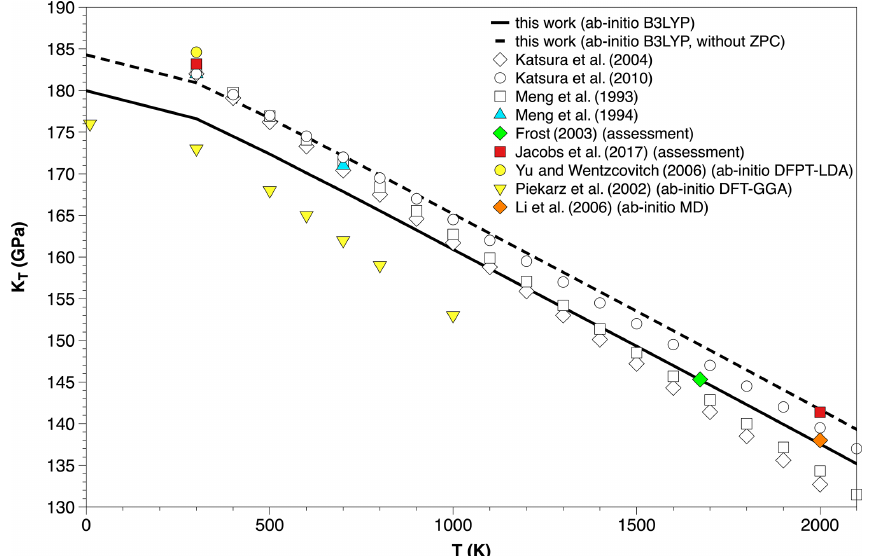
Figure 2. Temperature dependence of the isothermal bulk modulus ( K T ) of Mg 2 SiO 4 ringwoodite at zero or ambient pressure. Ab initio B3LYP results (with or without zero-point correction) are compared with available experimental data (Meng et al., 1993, 1994; Katsura et al., 2004, 2010), thermodynamic assessments (Frost, 2003; Jacobs et al., 2017) and previous ab initio DFT or MD simulations (Piekarz et al., 2002; Yu and Wentzcovitch, 2006; Li et al., 2006). Table 1. Ab initio B3LYP thermal EOS parameters, as calculated in this work at P = 0 and different T conditions. Results obtained by experiments (M’94 – Meng et al., 1994; K’04 – Katsura et al., 2004; K’10 – Katsura et al., 2010), thermodynamic assessments (D’15 – 2006) and first-principle molecular dynamics calculations (Li’06 – Li et al., 2006) are also shown. K T is the isothermal bulk modulus (in (cid:17) (cid:16) ∂K T are the first derivatives of K T with respect to P and T , respectively; GPa); K (cid:48) and T ∂T P at T =